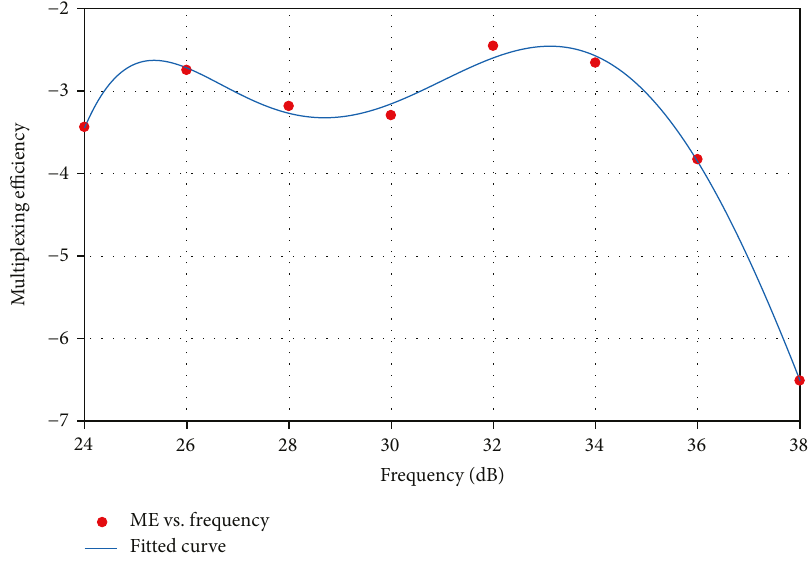
Figure 13: Multiplexing e ffi ciency of the proposed UWB MIMO